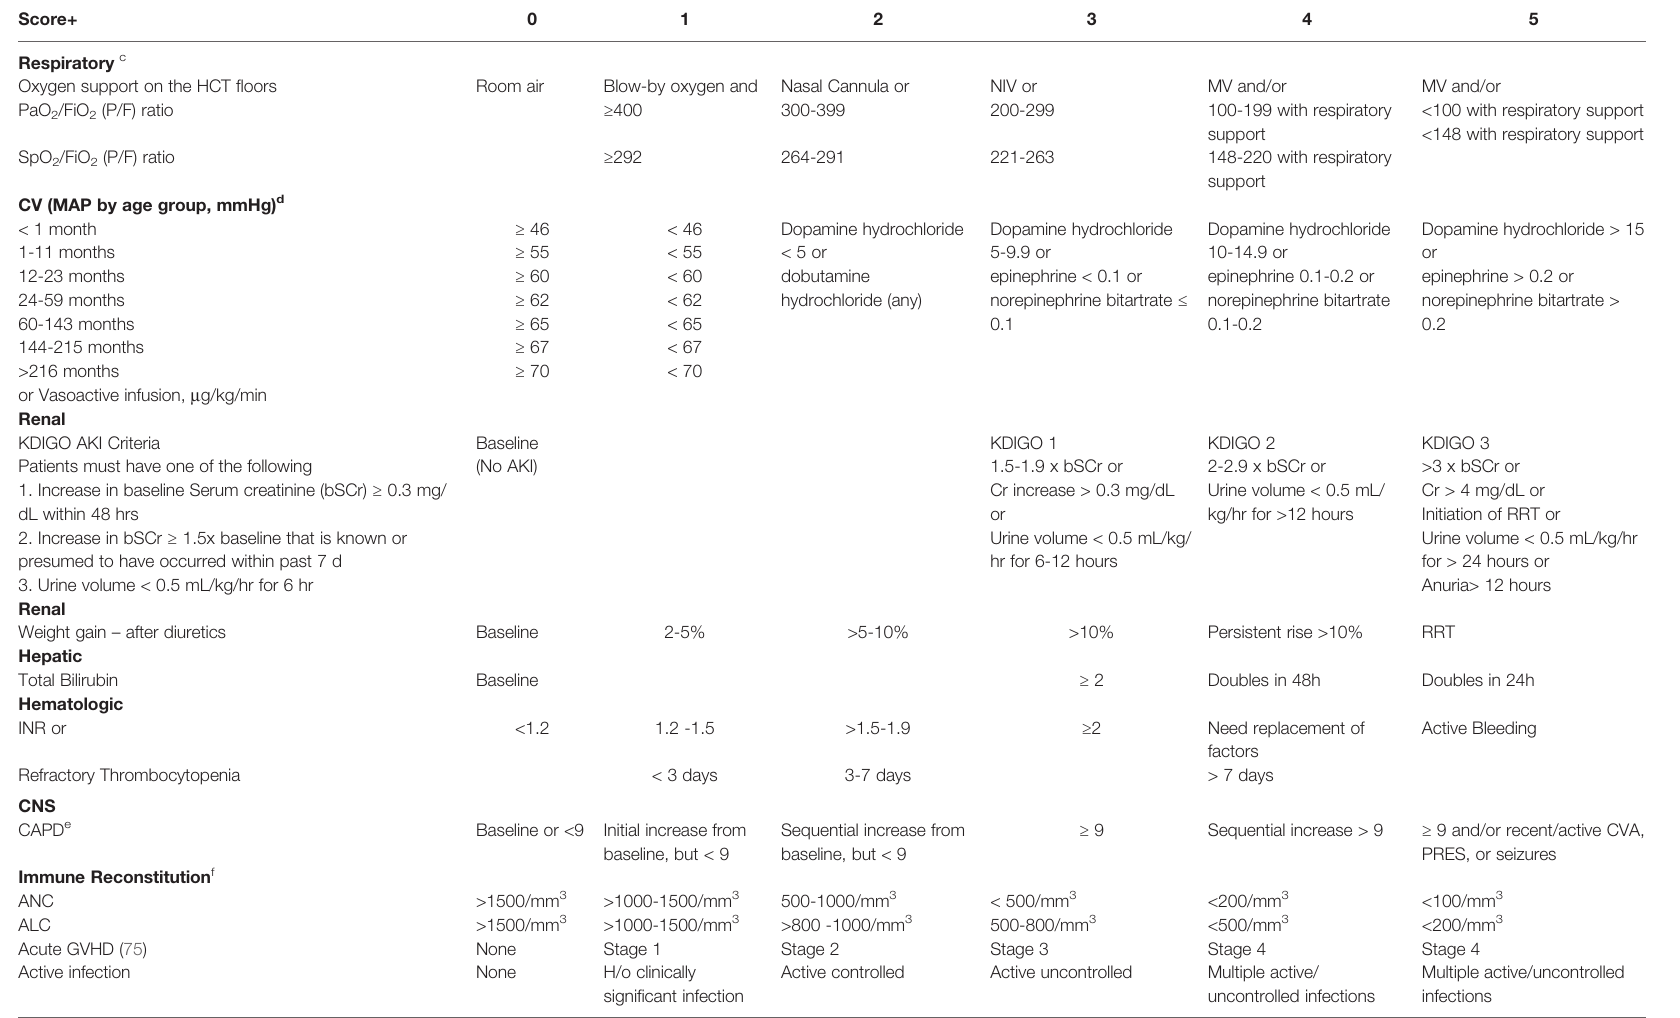
a.Maybeperformedweeklyandifclinicallysigni fi cantdeterioration.Usetheworstvalueinpreceding24-hourperiodforeachvariableb.IfconcernforpMODS,recommendfurtherscreeningforendotheliopathiessuchasCLS,ES,TMA,DAH, IPS,and/orSOS.c.P/Fratiotobeusedwhenarterialbloodgasisavailable.Otherwise,useS/Fratio.d.MAP=(1/3xSBP)+(2/3xDBP)e.CAPDchangefrombaselineshouldalsobetakenintoconsiderationwhenusingCAPDscore.e.ANC: absoluteneutrophilcount[whitebloodcellcount(k/uL)x(%neutrophils+bands)x10f.ALC:absolutelymphocytecount[whitebloodcellcount(k/uL)x(%lymphocytes)x10+patientsreceivingendoflifecaremaybedelineatedwithanorgan scoreand “ E ” (example4E);thisdesignationisintendedtoretainawarenessofspeci fi cgoalsofcareandexplicitlystaterationalewheninvasiveorgansupportinterventionsarenotinitiated.f.Assignthehighestscoreifany1criteriaismetinthis